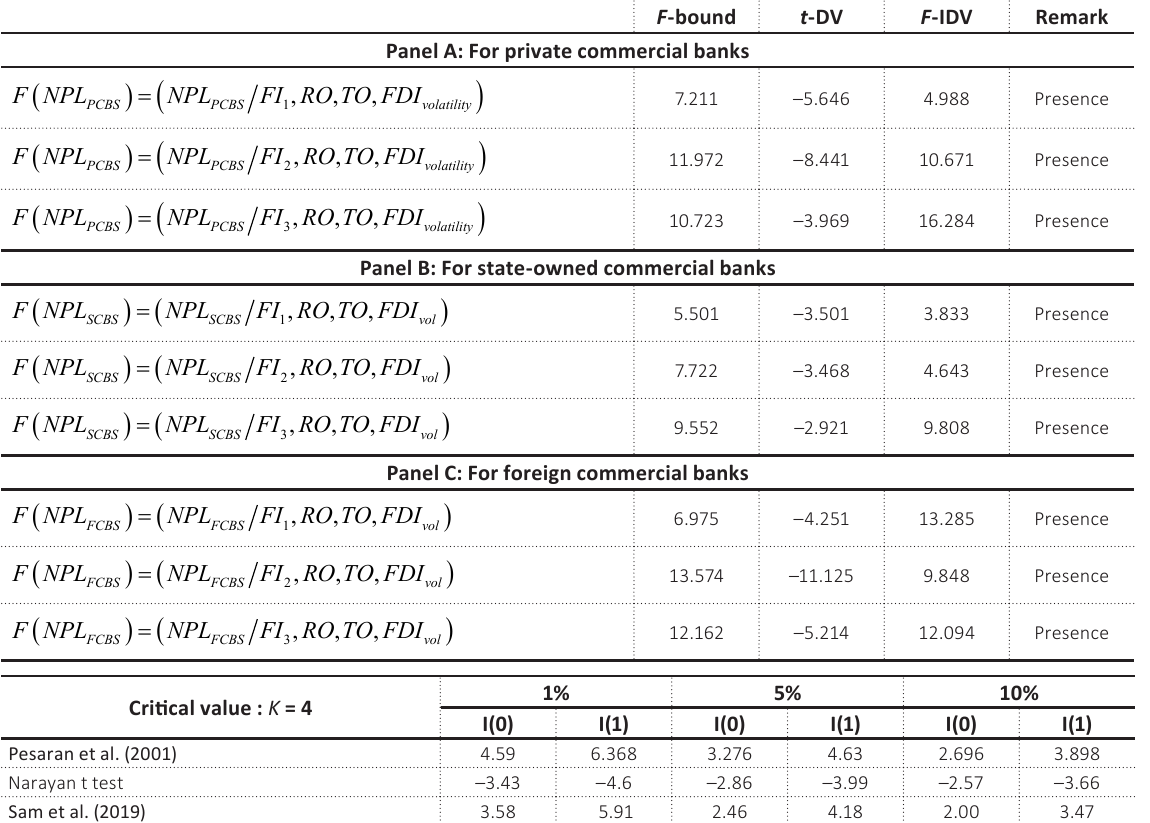
Table 5. Augmented ARDL cointegration test